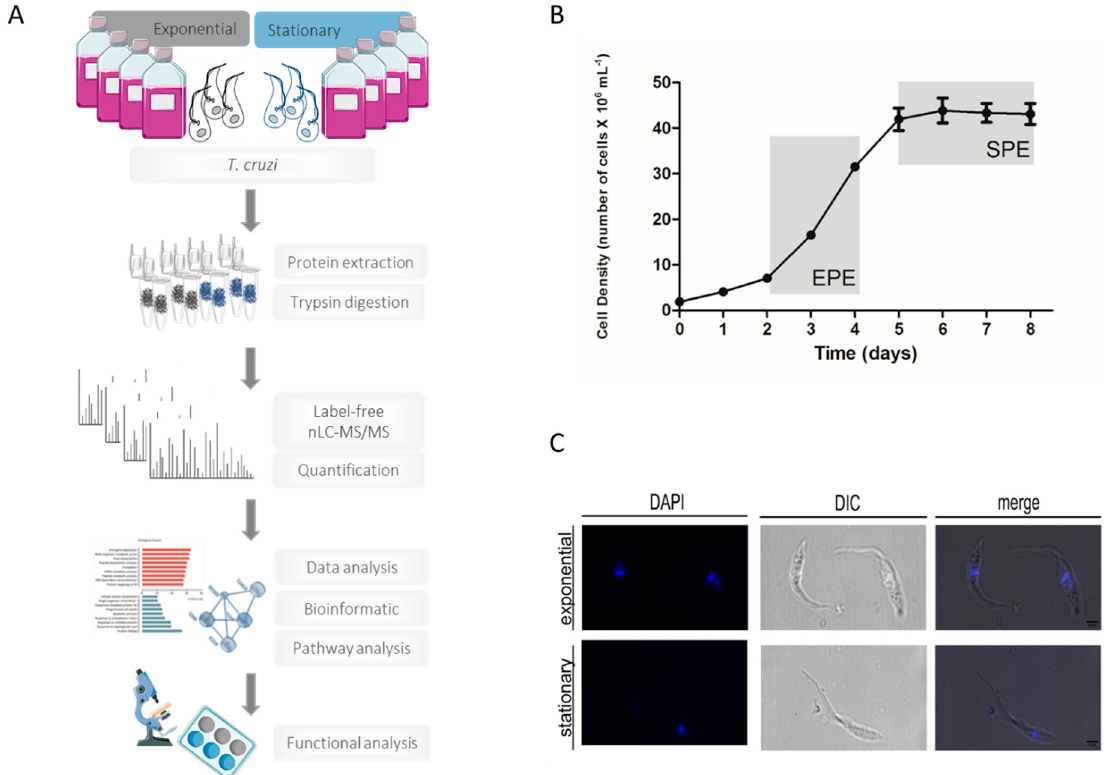
Figure 1. Mass spectrometry-based proteomics approach to assess the regulation of proteins during transitioning from exponential to stationary phase in Trypanosoma cruzi cells. ( A ) Proteomics workflow for identification and quantification of regulated proteins in T. cruzi during growth phase transitioning. T. cruzi epimastigote cells were taken during the exponential and stationary phase before protein extraction and tryptic digestion. Tryptic peptides were analyzed by nano-liquid chromatography tandem mass spectrometry (nLC-MS/MS) analysis. After data and bioinformatic analysis combined with functional studies, this approach made possible the assessment of protein regulation during T. cruzi exponential to stationary phase transitioning. ( B ) Epimastigotes growth curve presenting typical exponential and stationary phases with physiological differences. Optic microscopy representative images show the different shape of the exponential and stationary phases of the parasite. ( C ) Microscopic analysis of T. cruzi epimastigotes at the exponential and stationary phases using phase-contrast microscope and DAPI staining. DIC: differential interference contrast. Scale bar: 4 μ m.